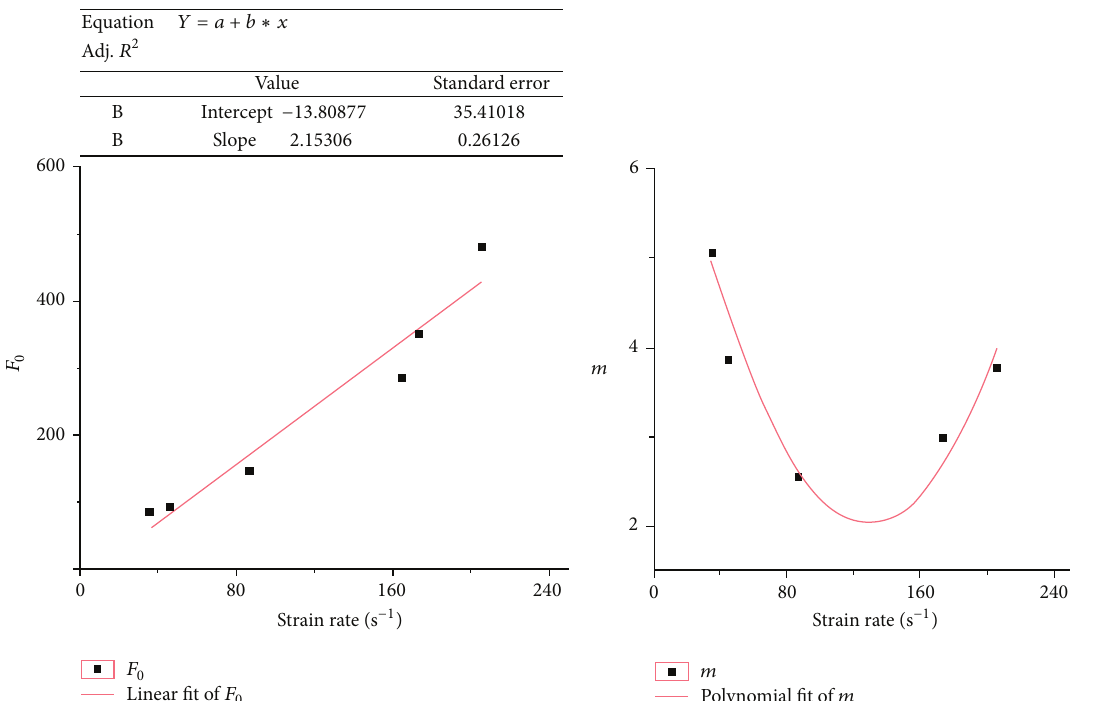
Figure 6: The relationship between model parameters 𝐹 0 and 𝑚 with strain rate ̇𝜀 .